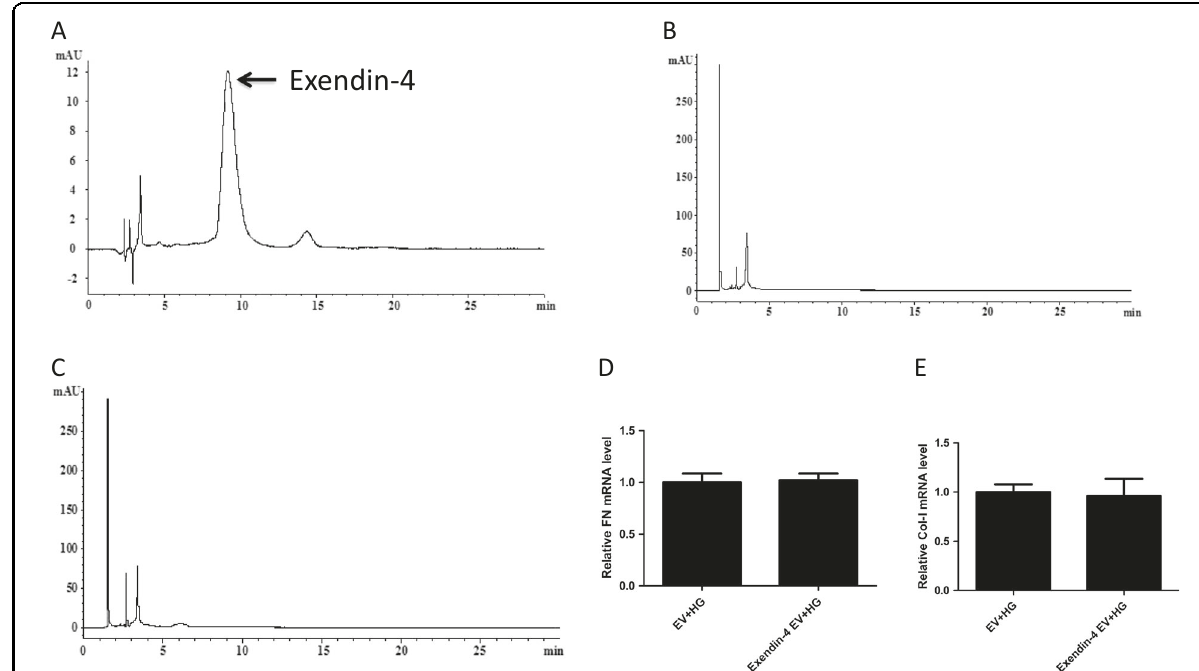
Fig. 3 Exendin-4 group-derived EVs loaded little exendin-4. a The HPLC chromatogram from the standard sample of exendin-4 in PBS (1 mg/ml). b The HPLC chromatogram from NG group-derived EVs. c The HPLC chromatogram from exendin-4 group-derived EVs. d , e Relative expression of Col-I and FN in HG-treated HK-2 cells co-cultured with exendin-4 group-derived